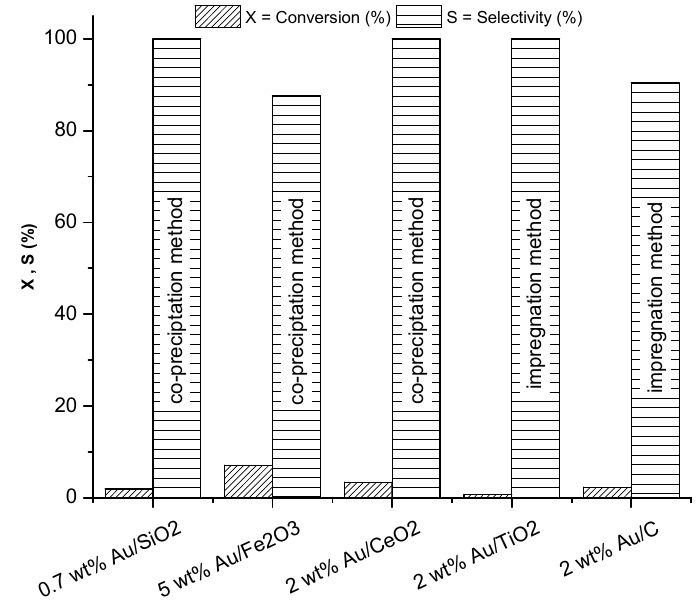
Figure 5 . Solvent-free oxidation of benzyl alcohol to benzaldehyde using Au catalysts. Reaction